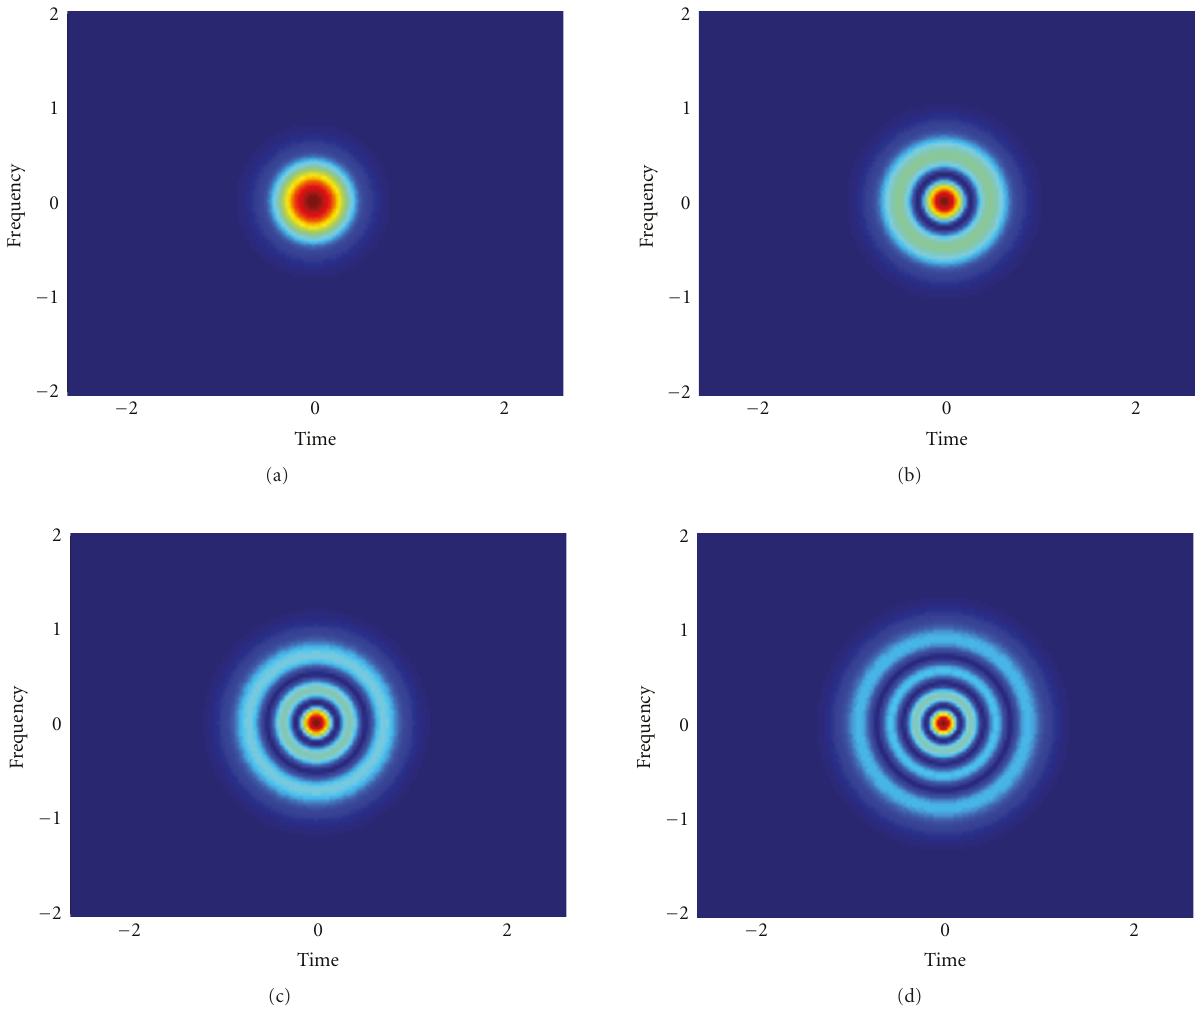
Figure 5: WD of (a) 0th-order, (b) 1st-order, (c) 2nd-order and (d) 3rd-order Hermite